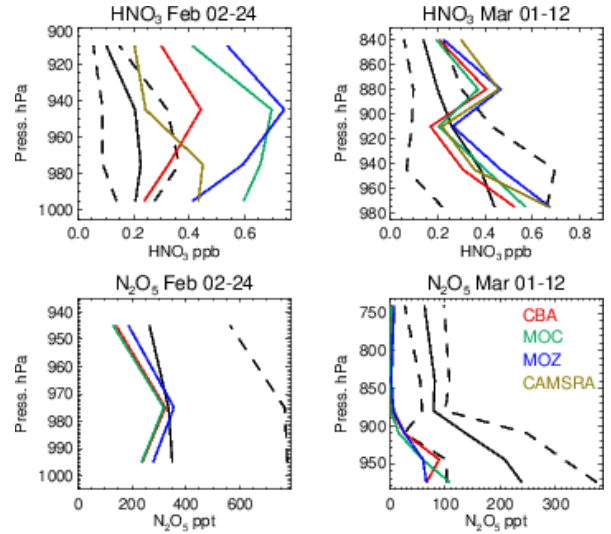
Figure 16. Comparisons of N 2 O 5 and HNO 3 for the WINTER cam- paign using nighttime flights. The black line represents the obser- vational mean value, with the associated standard deviation being shown as the dashed